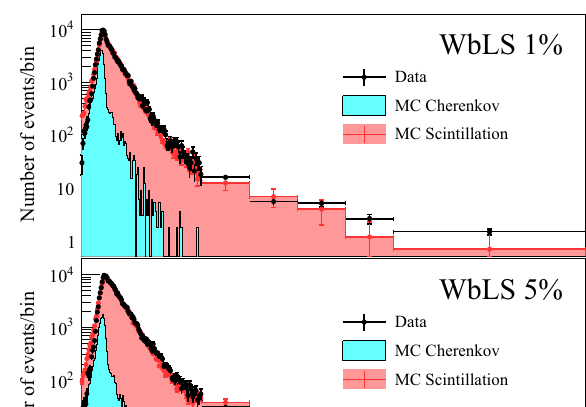
Cherenkov and scintillation separation. Beyond that region, our model and [12] diverge both due to the lack of sensi- tivity to the third exponential decay, which is driven by the large statistical uncertainties in the tail of the distributions, and our MC-based fitting approach, which limits the size of the parameter space (adding a third decay exponential would add an additional dimension to be scanned, complicating the fit procedure to an extent that was deemed unnecessary given our limited sensitivity to the long tail). For this analysis, our two-decay exponential model is